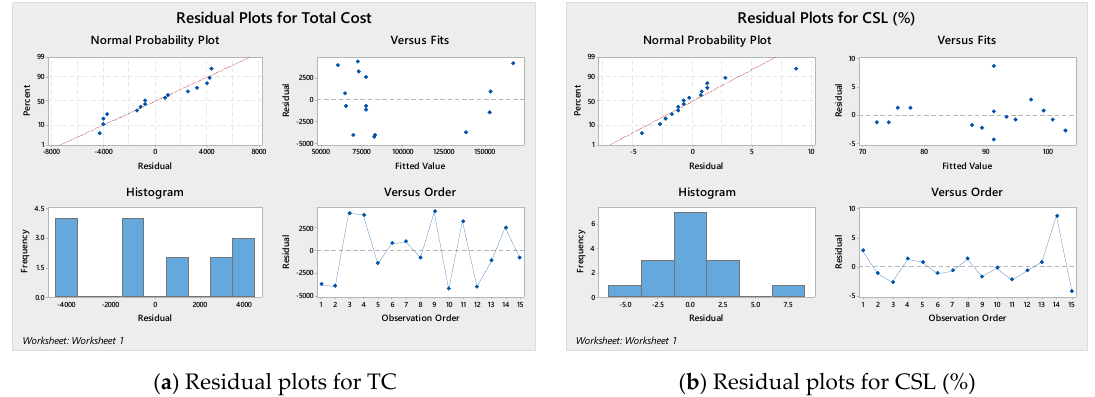
Figure 19. BBD—response surface regression of CSL (%) versus T, Q, and SS (reduced model). After reducing the BBD model into the final form, the residual plots (normal probability plot, histogram, versus fits, and versus order plot) for the response variables (TC and CSL) are displayed in Figure 20. The results show that all residual plots satisfied the normality and constant variance assumptions, which means the simulated data was random and followed normal distribution.